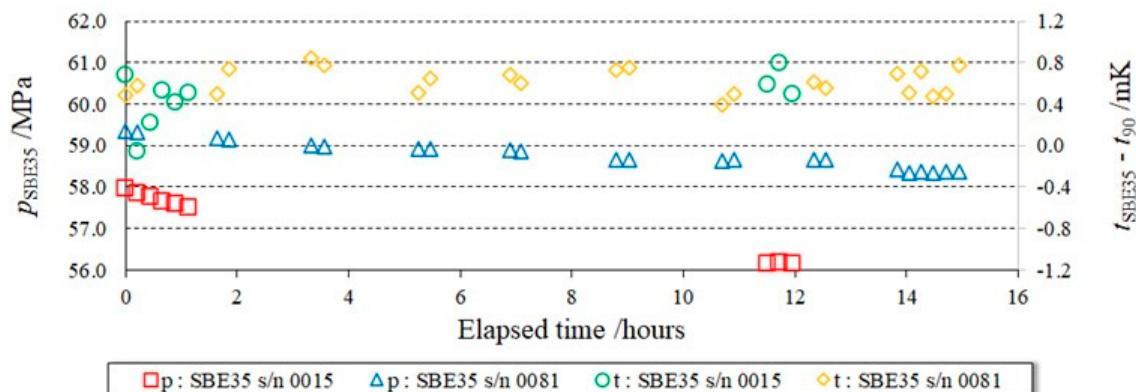
Figure 9. Pressure drift (left scale) and consequent temperature drift (right scale) during measurements at the highest pressure ( ≈ 60 MPa).